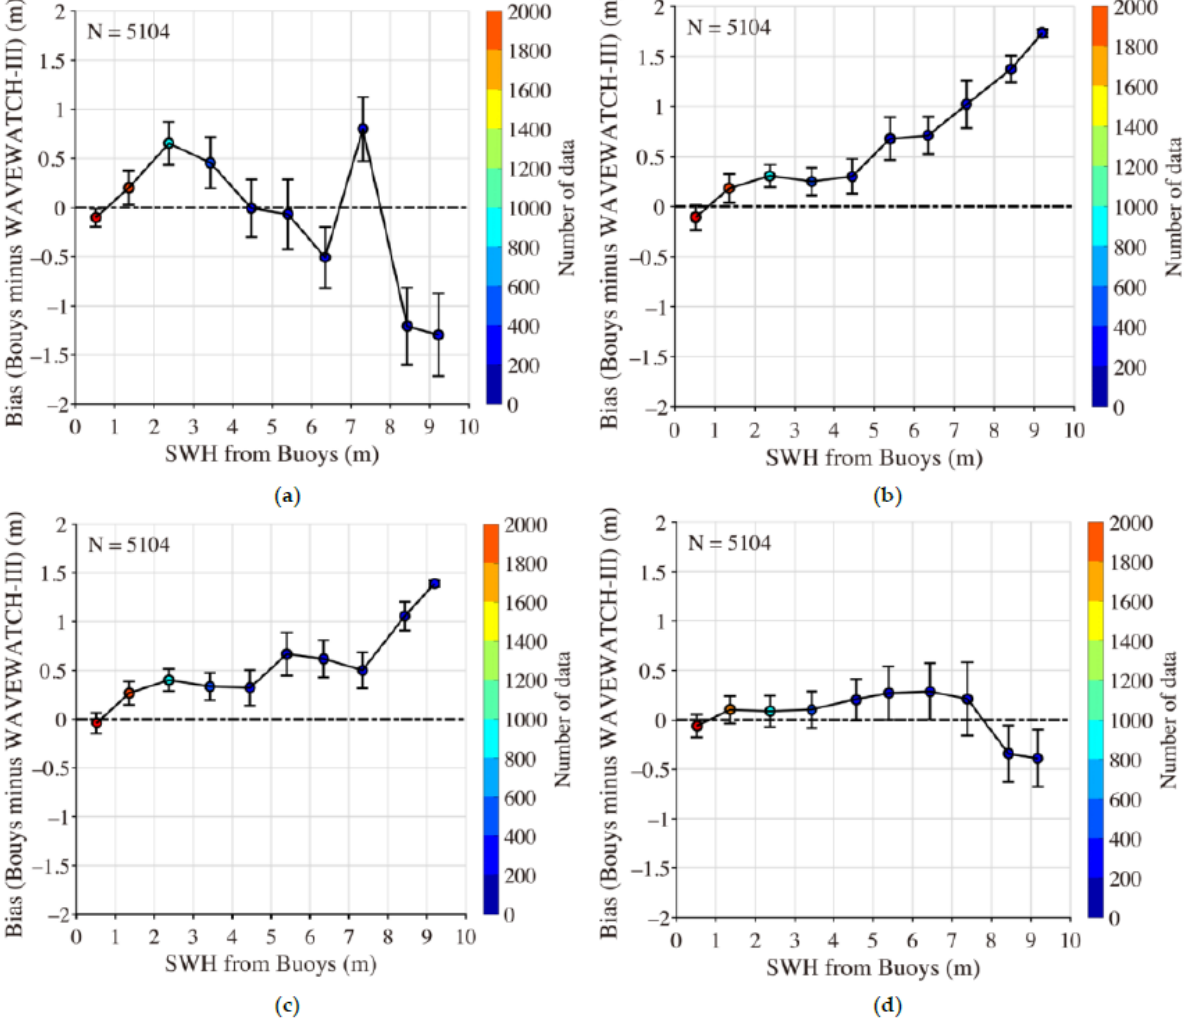
Figure 11. The statistical analysis of bias (buoys minus WW3-simulated H s ) compared with the measurements from all available buoys using the parameterizations adapted from [2] ( a ), [57] ( b ), [59] ( c ), and this study ( d ), in which the error bars represent the standard deviation for a 1 m bin of H s up to about 10